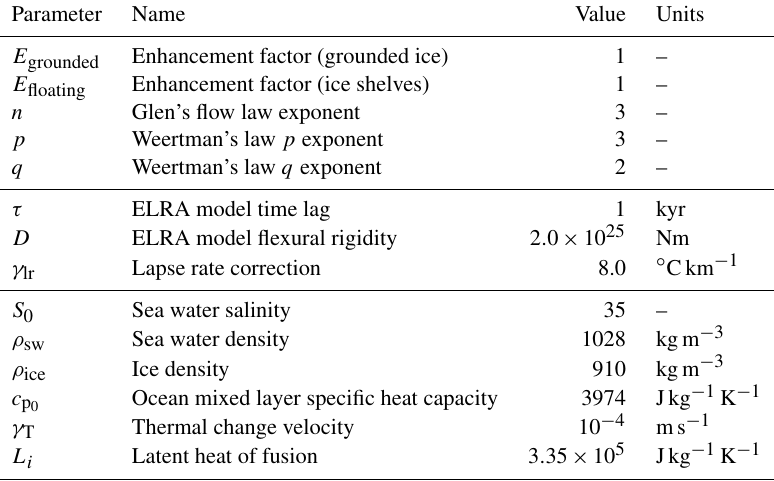
Table 1. Main parameters used in the experiments. Parameter